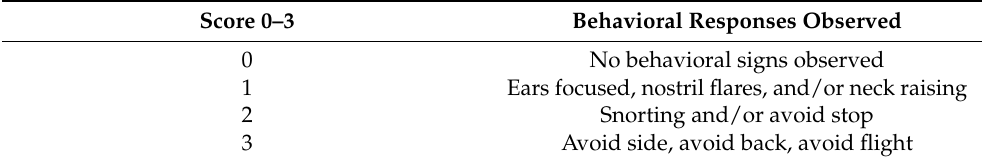
Table 3. Reaction Scale used to quantify behavioral responses (adapted from Christensen et al. [15]).